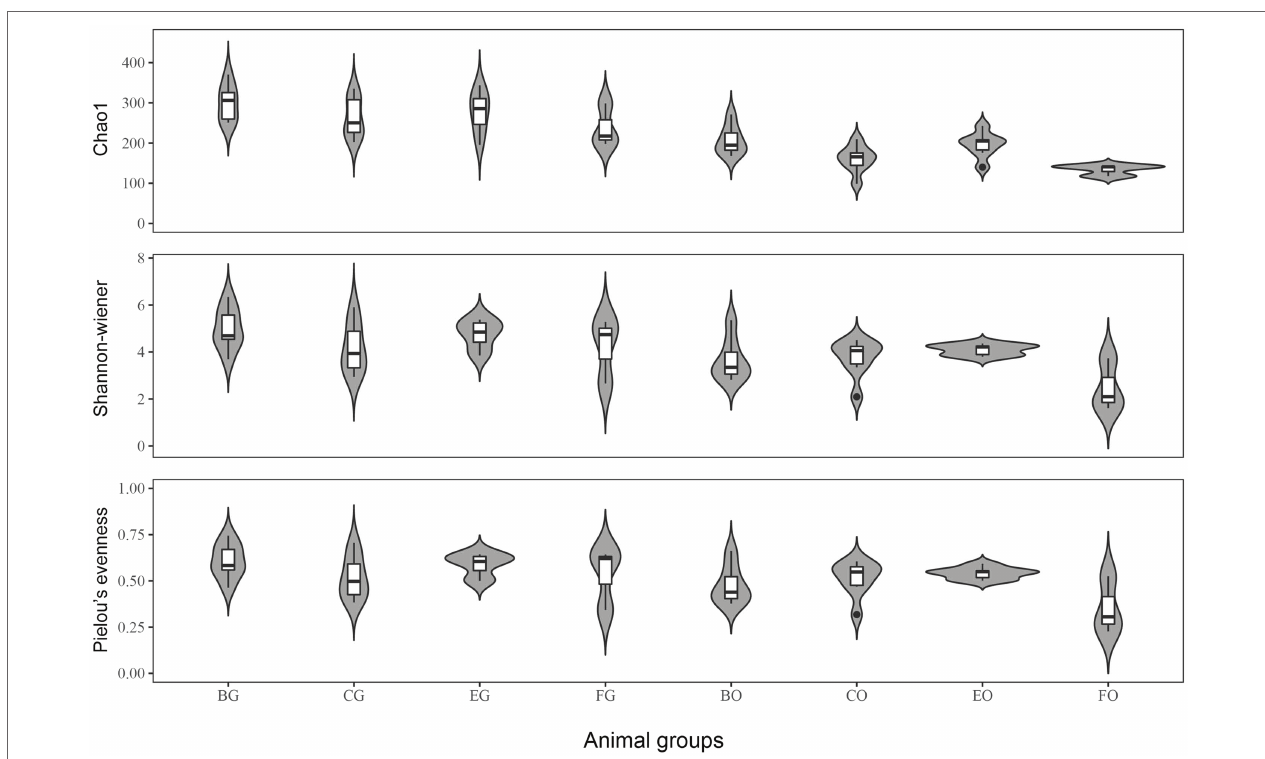
FIGURE 2 | The alpha diversity indexes of gut microbiota among the four animal groups, including Chao1, Shannon-Weiner and Pielou’s evenness. See Figure 1 for the definition of every